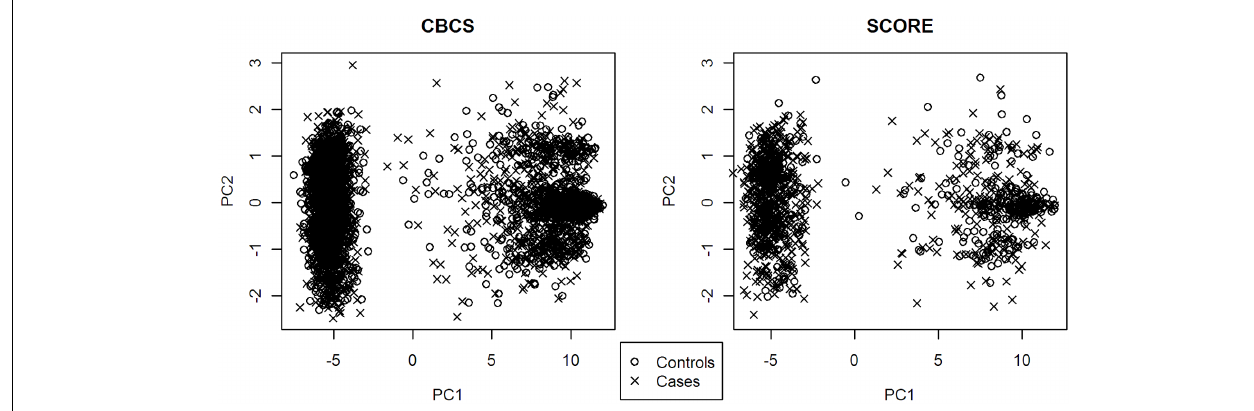
FIGURE 2 | Scatter plots of PC1 vs. PC2 for CBCS and SCORE by case–control status.